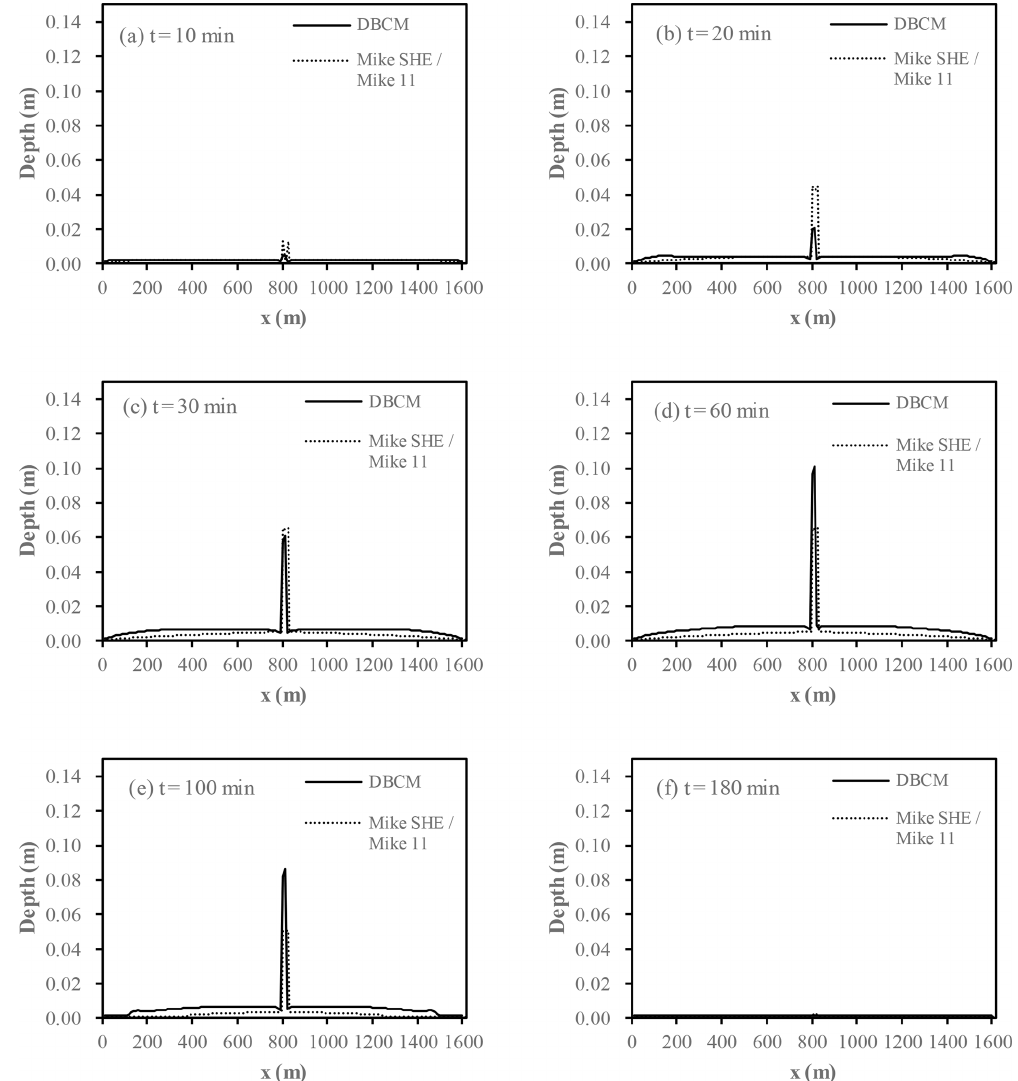
Figure 12. Comparison of water depth profile between DBCM and MIKE SHE–MIKE 11 at the downstream catchment ( y = 500m).